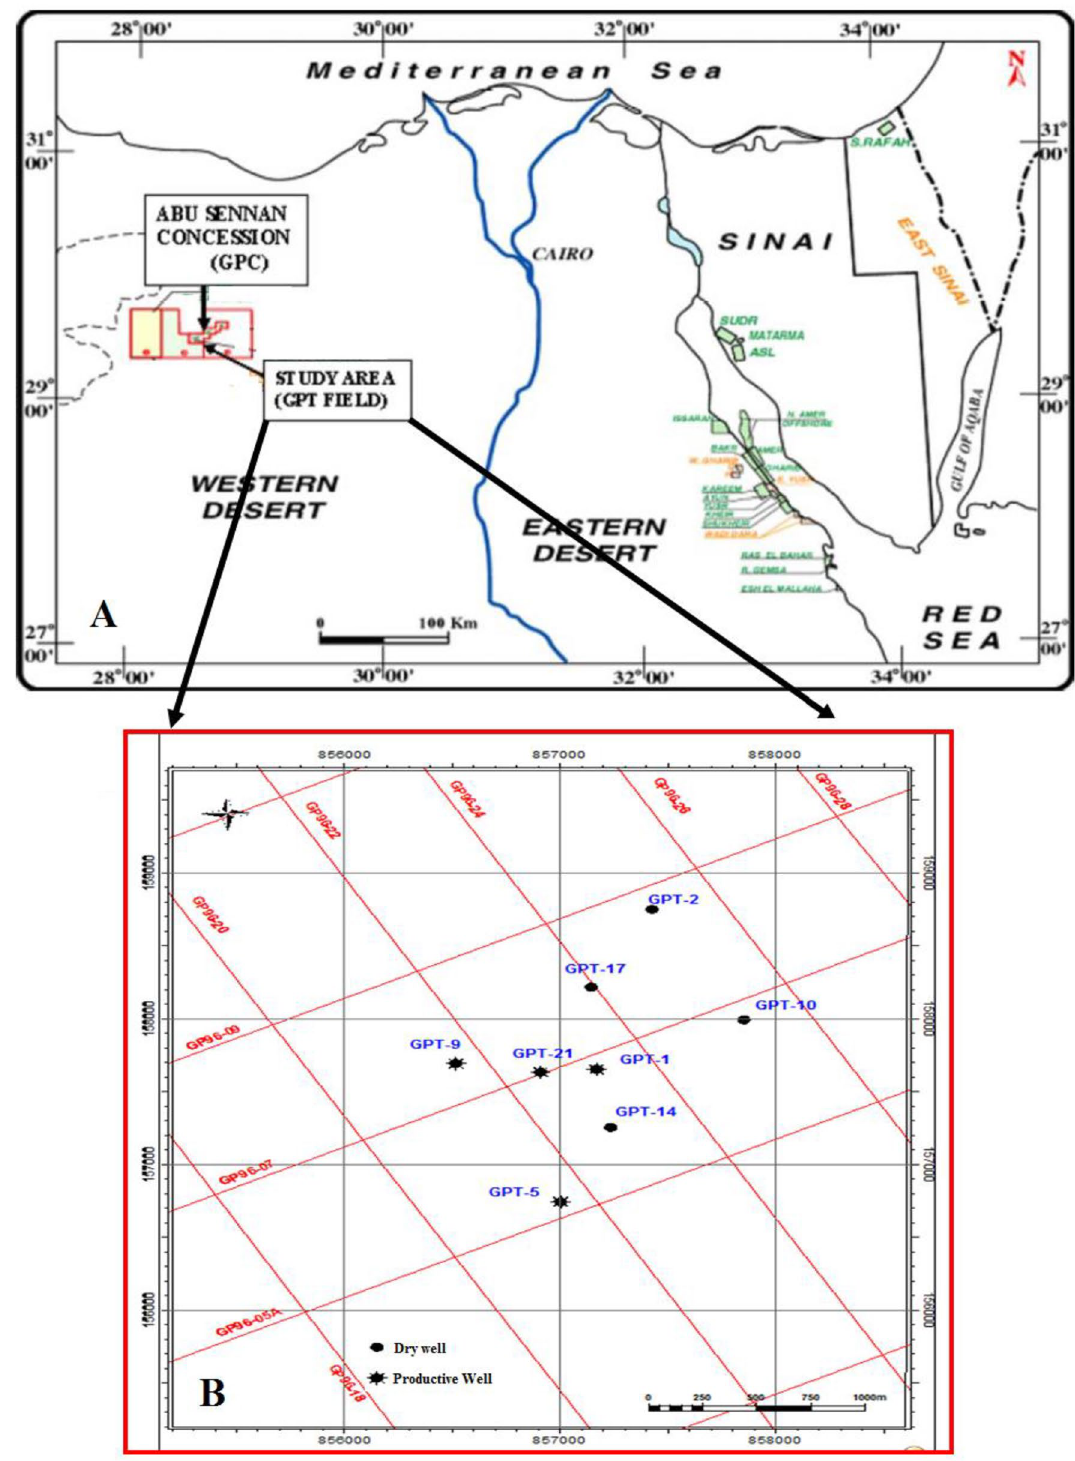
Fig. 1 a Location map of the study area. b Shot point and base map of the studied